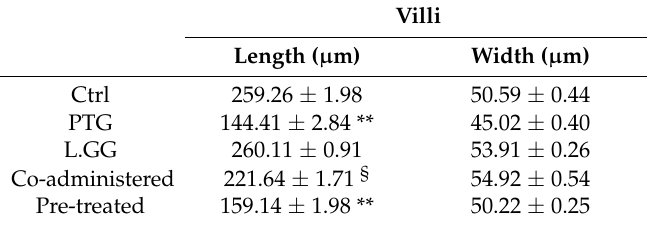
Table 1. Morphometric evaluation of jejunal tissue sections from control and treated rats.